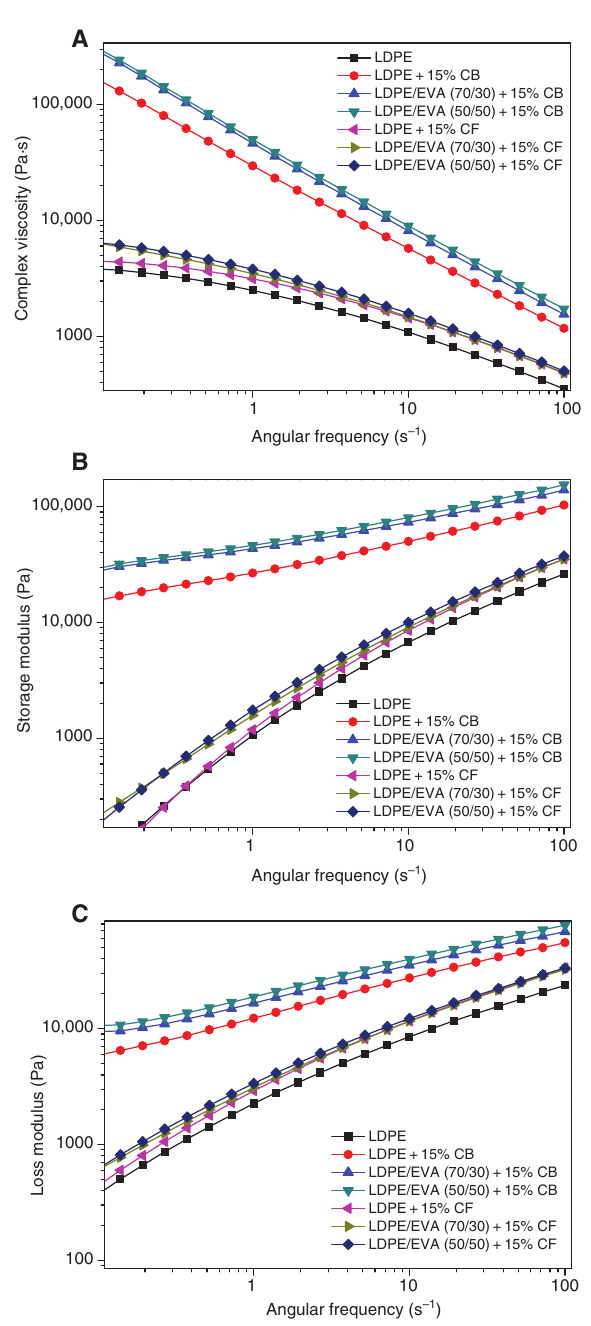
Figure 9: Dynamic rheological curves of LDPE/EVA/CB and LDPE/ EVA/CF composites. (A) Complex viscosity vs. angular frequency; (B) Storage modulus vs. angular frequency; (C) Loss modulus vs. angular frequency.